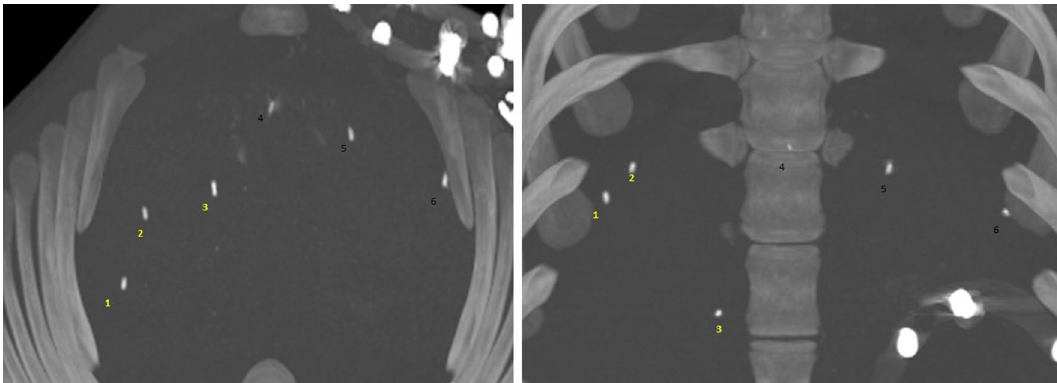
Figure 4. Screenshot of the planning software (home-made software). The needle trajectory (in yellow) is planned by defining the entry (skin) and the target points.